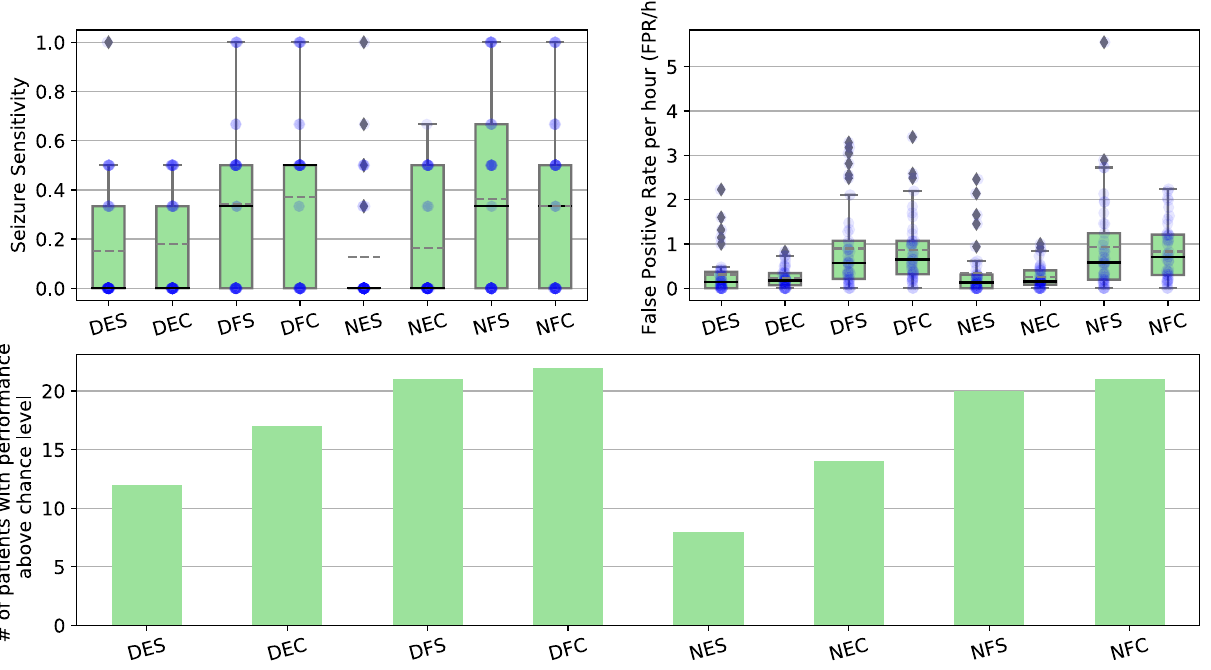
Figure 5. Boxplots with the overall seizure sensitivity and FPR/h for the DES (Denoised EEG Standard ), DEC (Denoised EEG Chronological ), DFS (Denoised Features Standard ), DFC (Denoised Features Chronological ), NES (Noisy EEG Standard ), NEC (Noisy EEG Chronological ), NFS (Noisy Features Standard ), and NFC (Noisy Features Chronological ) approaches. Continuous black lines represent medians, dashed grey lines correspond to the averages, diamonds symbolise outliers, and the distributions of the results for each patient are presented as blue circles. Bar charts show the number of patients’ models with performance over chance using surrogate analysis.